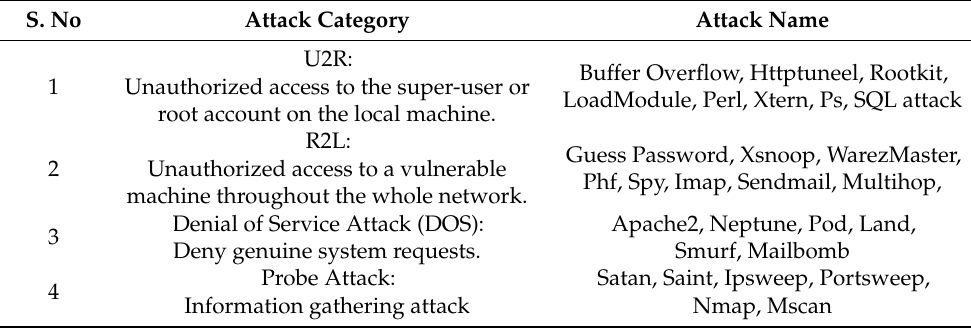
Table 1. NSL-KDD dataset attack